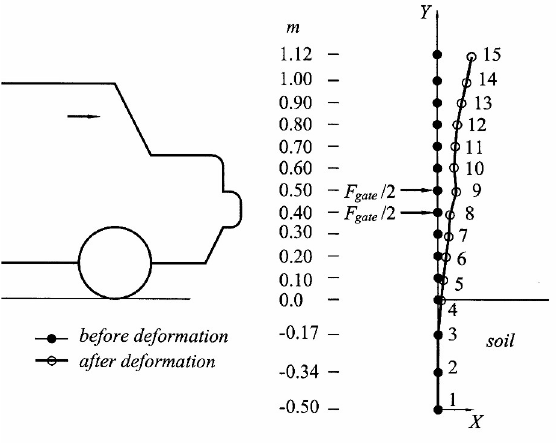
Fig 9. The computational scheme and the outcomes of the computer-run